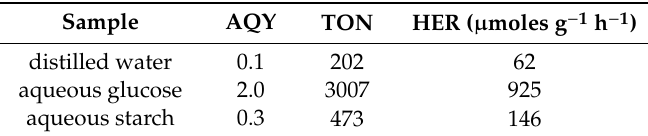
Table 4. Apparent quantum yield (AQY) and turn over number (TON) values for DMASnBr 3 / g-C 3 N 4 (0.5 g L − 1 catalyst, 0.5 wt% Pt).